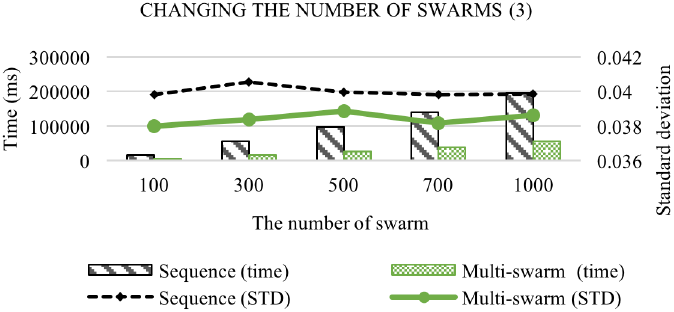
Fig. 2. Changing the number of swarms with the parameters in Table 3, column (3).